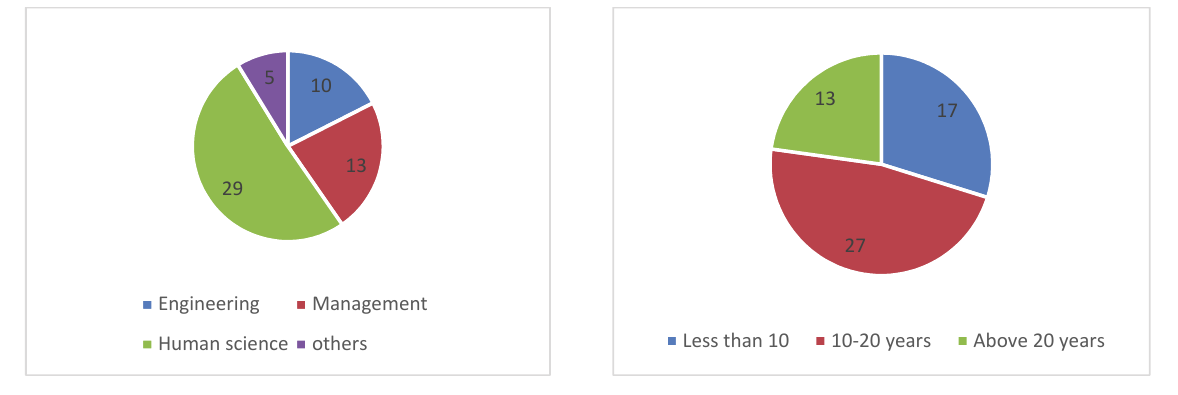
Fig. 2. Personal characteristics of the participants